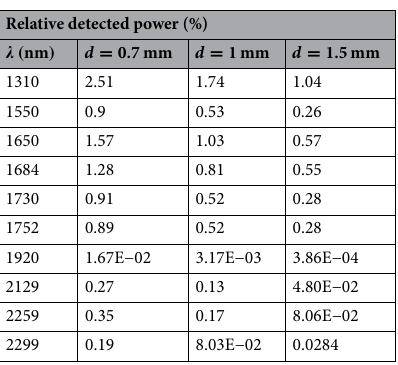
Table 2. Relative output power at different sensor